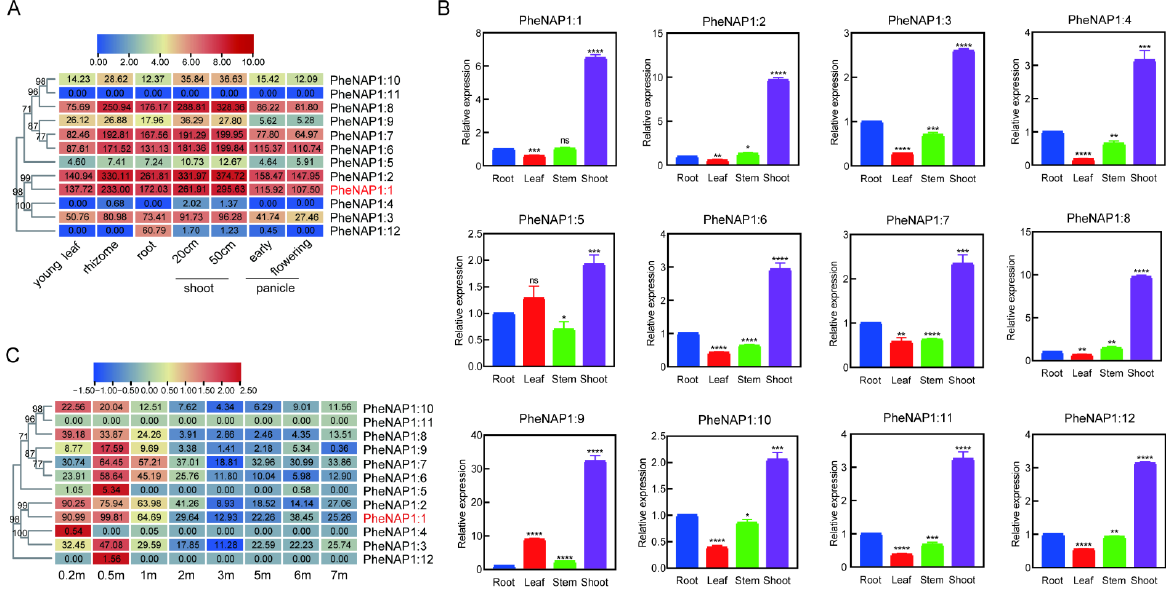
Figure 3. Expression profiles of PheNAP1 family genes in Phyllostachys edulis . ( A ) The clustering heatmap shows the expression patterns of PheNAP1 in different tissues (leaf, root, shoot, and panicle) using transcriptome data. ( B ) Expression of PheNAP1 family genes in the root, leaf, stem, and shoot by RT-qPCR analysis. We performed three biological replicates and three technical replicates. Error bars indicate standard deviation. *: p <0.05; **: p <0.01; ***: p <0.001; and ****: p <0.0001. ( C ) The clustering heatmap indicates the expression pattern of PheNAP1 in fast-growing shoots with heights from 0.2 m to 7 m using transcriptome